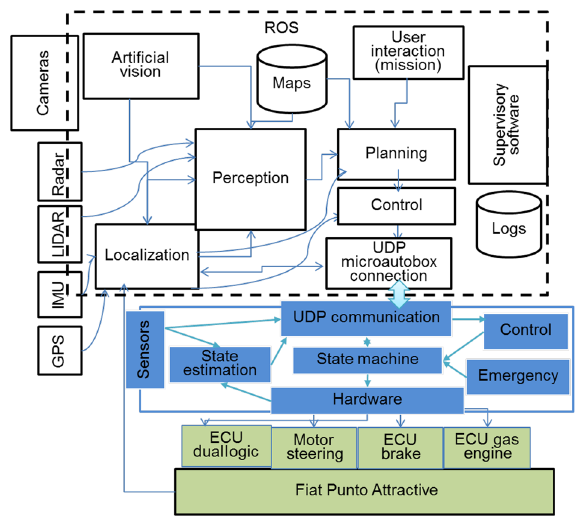
Fig. 4 Framework architecture of VILMA. Linux software (white), firmware (green), and embedded software